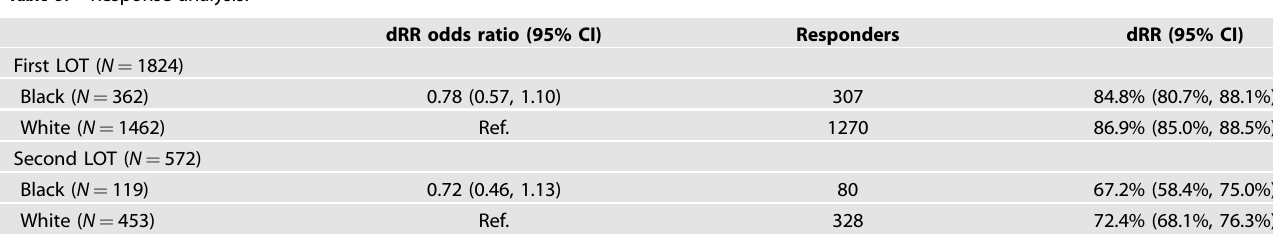
Table 3. Response analysis.